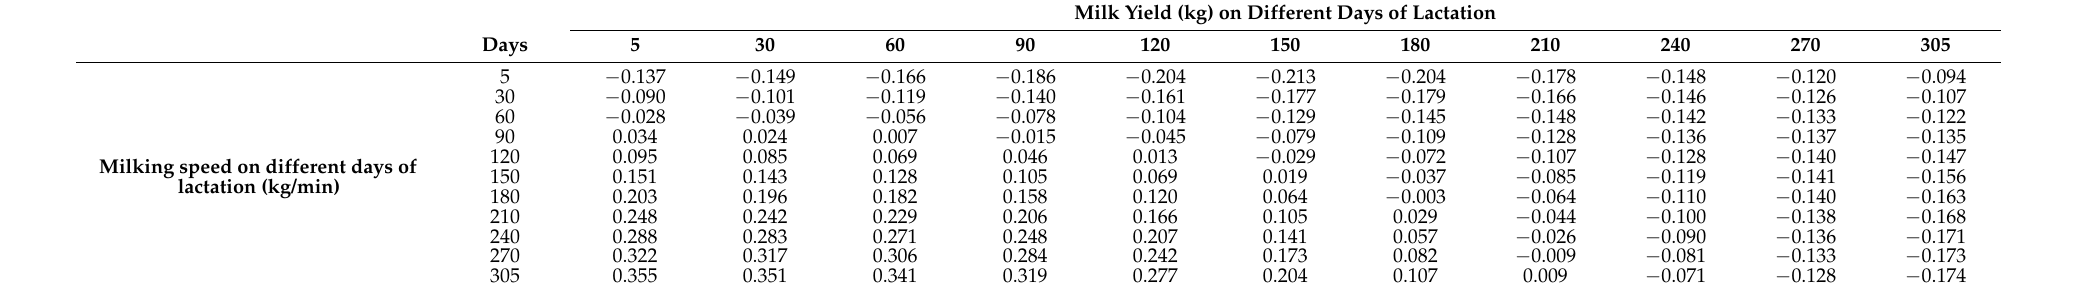
Table 9. Genetic correlations between milk speed and milk yield in different days of